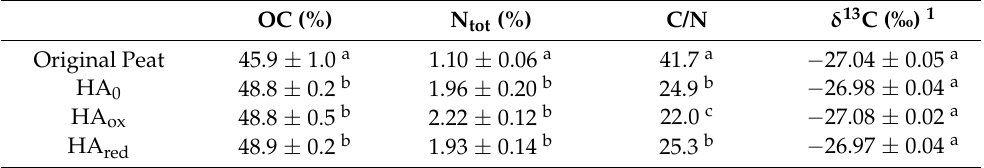
Table 1. Organic carbon (OC), total nitrogen (N tot ), and carbon stable isotope composition ( δ 13 C) of the original peat sample and of HA extracted before (HA 0 ) and after aerobic (HA ox ) and anaerobic (HA red ) incubations. Different letters (a,b,c) refer to significant differences (HSD test, p < 0.05). All data are expressed on a dry weight basis.